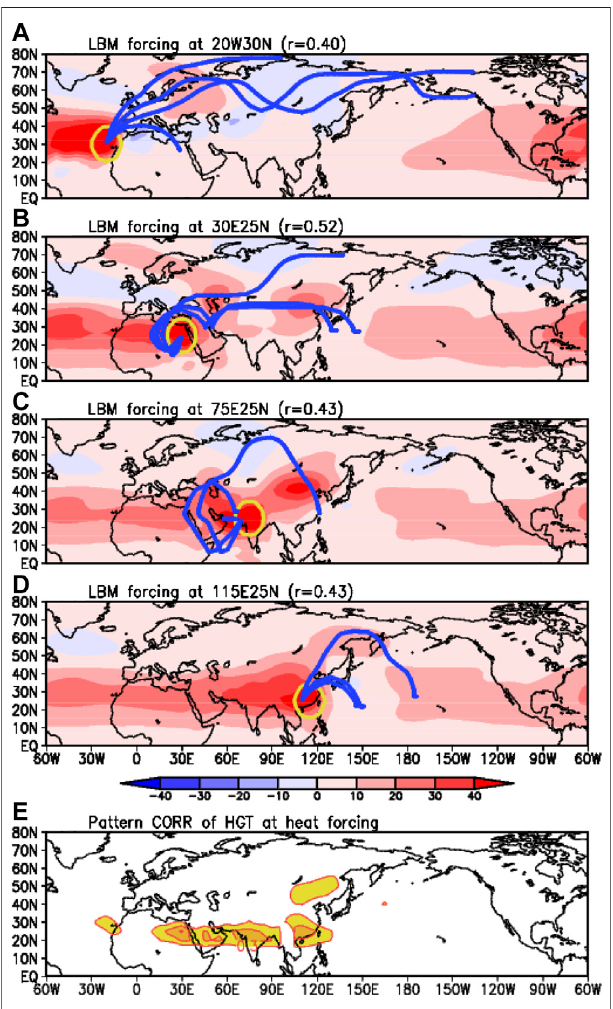
FIGURE5| TheLBM experimentusing diabaticheatforcingmigratingin 5 ° interval over the Northern Hemisphere. The geopotential height anomaly at 200 hPa in the LBM experiment is shown for forcing of (A) 20 ° W 30 ° N, (B) 30 ° E25 ° N, (C) 75 ° E25 ° N,and (D) 115 ° E25 ° N.Theyellowcircledenotes the heat forcing area, and the blue line shows the Rossby wave propagation path.ThepatterncorrelationbetweenthegeopotentialheightanomalyinLBM experiments and EOF1 ( Figure 1A ) is calculated in (E) . The correlation is shown at each forcing center, and the contour interval is 0.1.